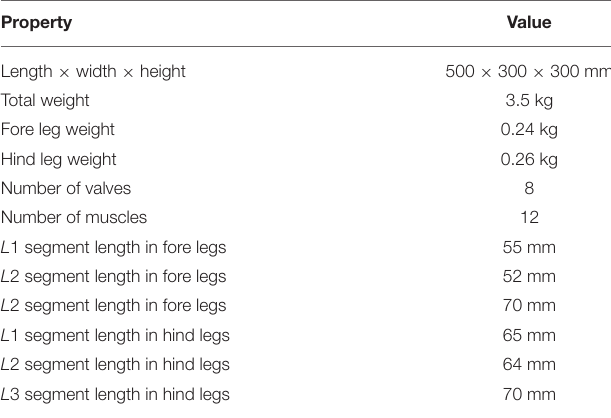
TABLE 1 | Key properties of